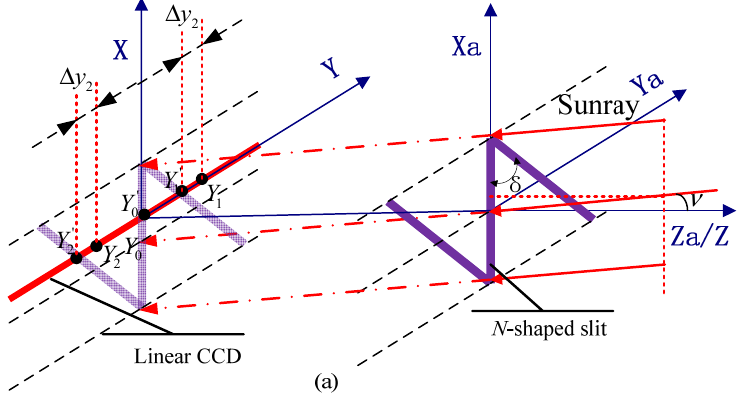
Figure 3. Principle schematic of digital sun sensor with N-shaped slit: (a) incident sunray deflects in the Xa-Za plane; (b) incident sunray deflects in the Ya-Za plane. (c) sunray travels at a random angle of